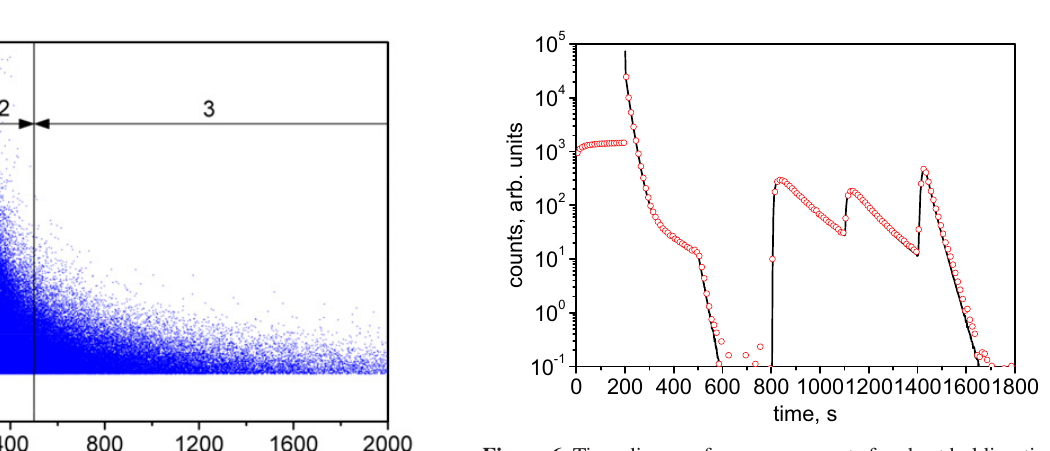
Figure 6. Time diagram for measurements for short holding time without the insert but with monitoring and with the absorber. Comparing the experiment (red circles) with the calculation (solid black line).